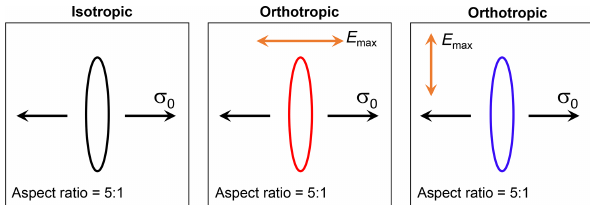
Figure 20. Schematic outline for models of narrow cracks in thin 2D orthotropic plates. The crack is subjected to a uniaxial tensile stress, and plane strain is assumed. The colours of the crack outlines correspond to the circumferential stress predictions in Fig.